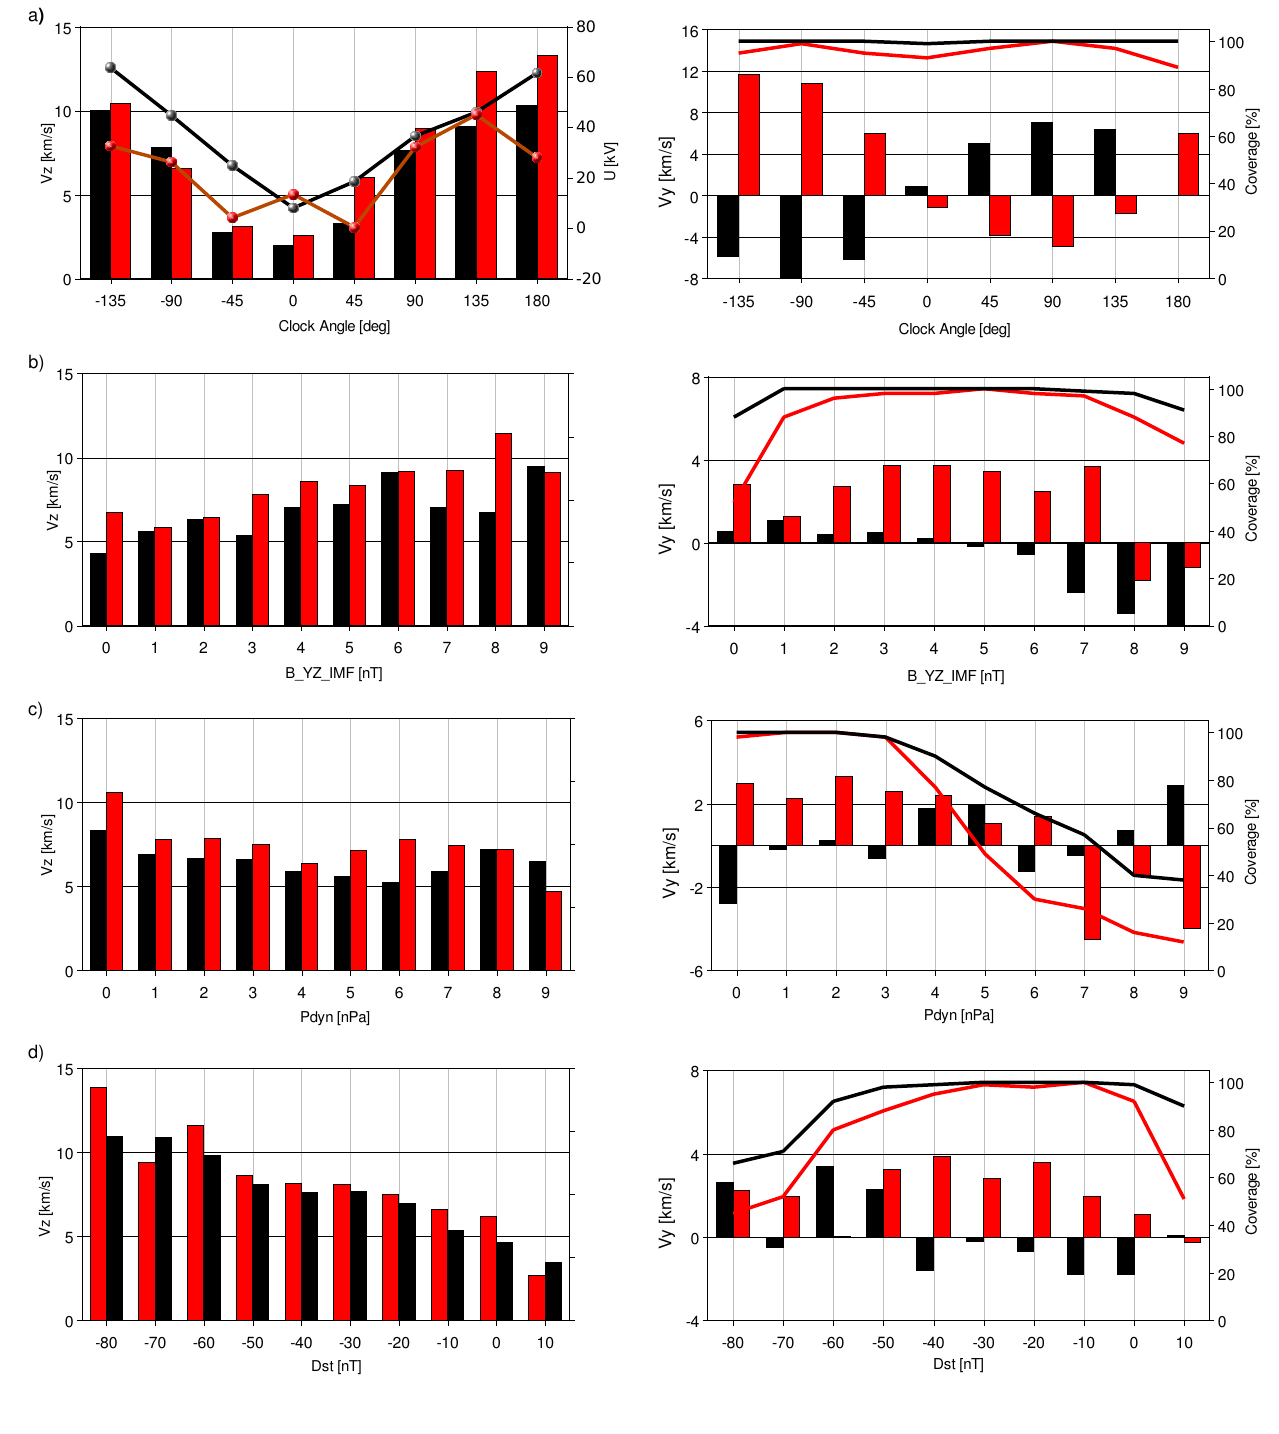
Fig. 5. Correlation between convection and solar wind and disturbance parameters. Left panels: Average convection velocities Vz (bars) and calculated cross tail potential (solid lines, top left panel only). Right panels: Corresponding Vy convection (bars) and data coverage (solid lines). Black (red) color indicates Northern (Southern) Hemisphere. For the upper panel, the numbers along the horizontal axis show the center of the clock angle sector, i.e. 0 means the average obtained from the 45 ◦ clock angle sector ranging from from − 22.5 to +22.5 degrees. For the other parameters, the numbers indicate the beginning of the range.